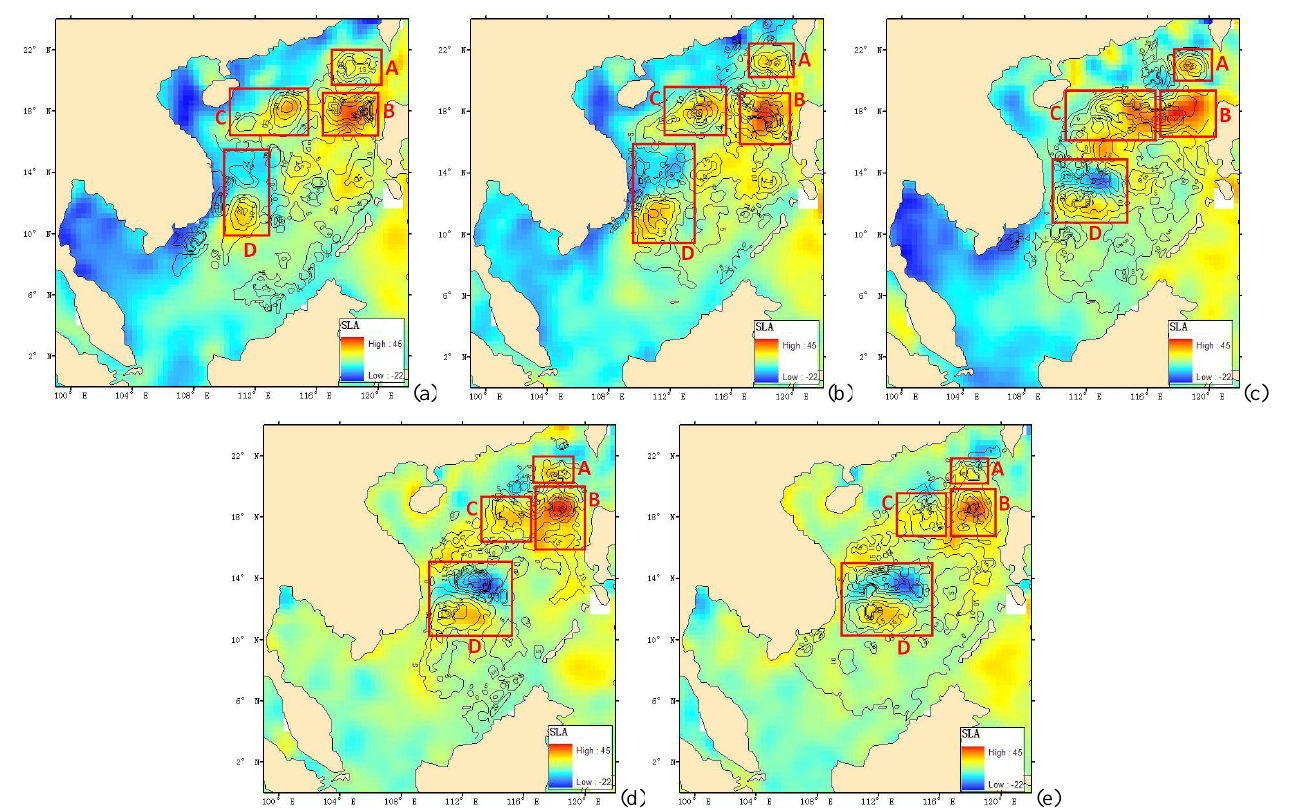
Fig. 5. Comparison of 5-days NLOM SSHA contours with AVISO SLA image in the SCS. Four deterministic eddies are marked as Warm Eddy off the Luzon Strait (red capital A), the West Luzon Eddy (red capital B), the Warm Eddy near Xisha Island (red capital C) and the Eddy Pair Offshore from Vietnam (red capital